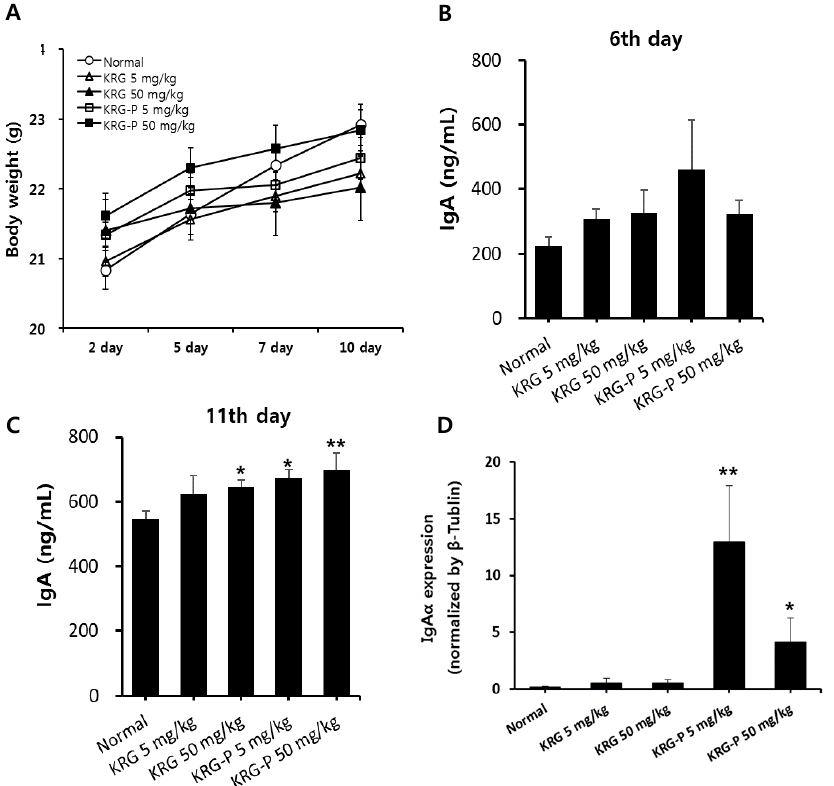
Figure 3. Effects of oral administration of KRG and KRG-P on mouse IgA production. ( A ) Five BALB/c mice per group were orally and daily administered with the indicated doses of KRG or KRG-P for 10 days. Bodyweight was estimated every two or three days. ( B , C ) Mouse fecal samples were collected on days 5 and 11 and analyzed for IgA expression by using mouse ELISA assays. ( D ) The mice were sacrificed at 11 days after oral treatment, and tissues from the jejunum region of the small intestine were then collected. Intestinal IgA mRNA levels were measured using qRT-PCR. Data are presented as the means ± SD of three independent experiments. * p < 0.05 vs. the normal group. ** p < 0.01 vs. the normal group.